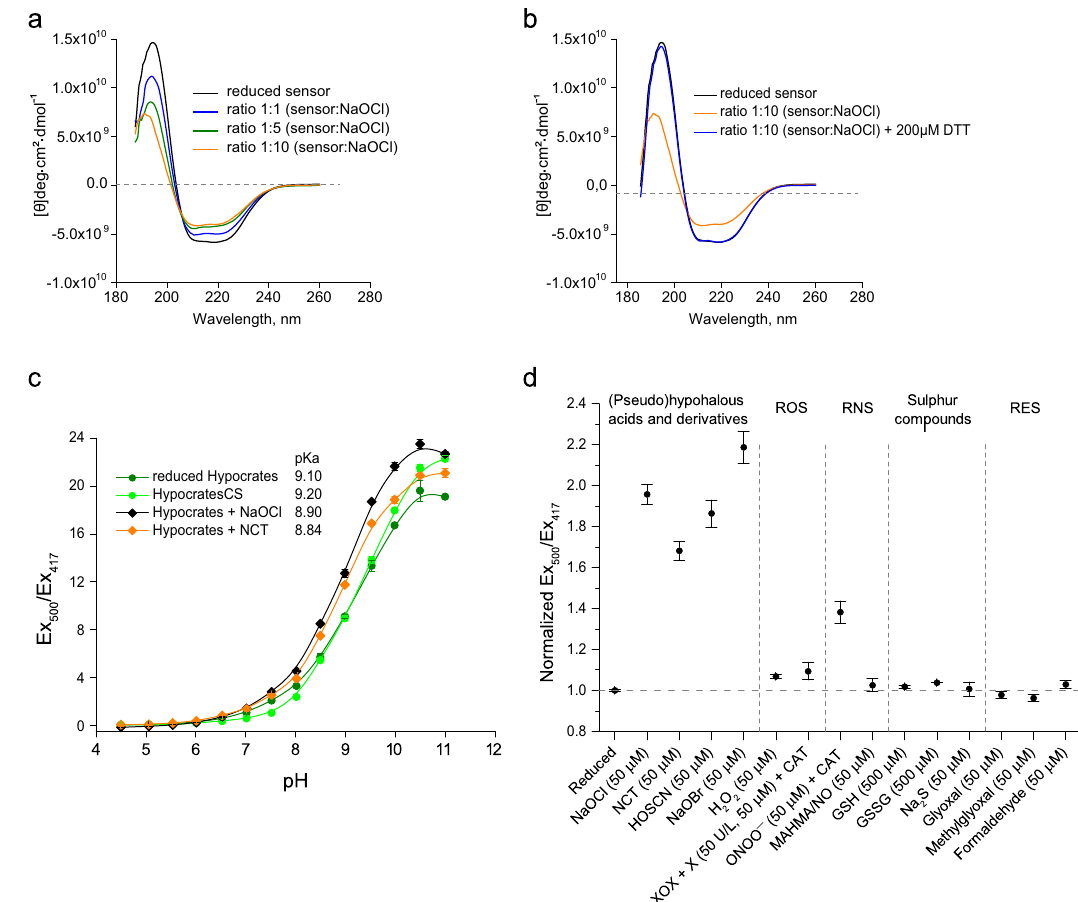
Fig. 2 The selectivity of Hypocrates. a Far-UV circular dichroism spectra of reduced and NaOCl oxidized Hypocrates. With increasing NaOCl concentration, an increase of the molar ellipticity [ θ ] at 208 nm and 222 nm and a decrease at 194 nm were observed. b Upon reduction with DTT, the NaOCl-treated biosensor restores its overall secondary structure to the reduced form. c The excitation ratio of reduced and oxidized Hypocrates depends on the pH value of the buffer solution. NCT – N-chlorotaurine. The data are presented as a mean ± SEM, n = 4 for reduced Hypocrates, n = 3 for other curves. d Selectivity pro fi le of puri fi ed Hypocrates (2 µ M) towards a set of various redox compounds. ROS - reactive oxygen species, RNS - reactive nitrogen species, RES - reactive electrophilic species, XOX - xanthine oxidase, X - xanthine, CAT - catalase. The data are presented as the mean ± SEM, n = 8 for NaOCl, n = 5 for NCT, n = 6 for ONOO − , n = 3 for other compounds. Source data are provided as a Source Data fi